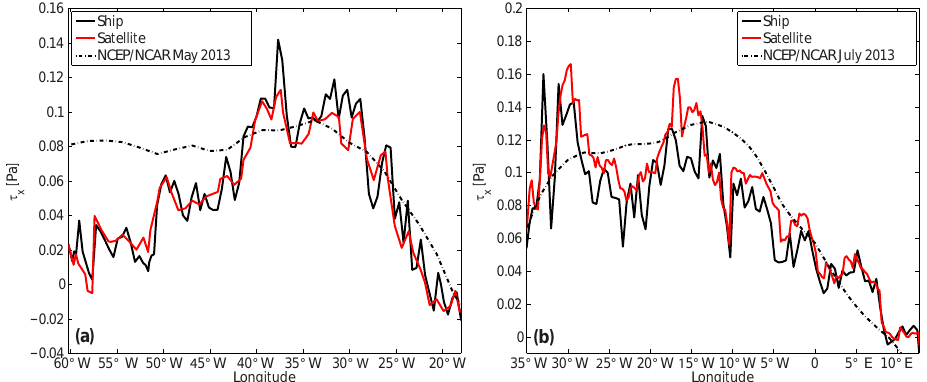
Figure 5. Zonal wind stress along (a) 14.5 ◦ N and (b) 11 ◦ S. Ship wind stress (black line) was binned in a 50km interval. The satellite wind stress data (red) were extracted to the nearest ship time and position. The NCEP reanalysis monthly zonal wind stress (black dashed line) at the same latitude in the cruise month is also